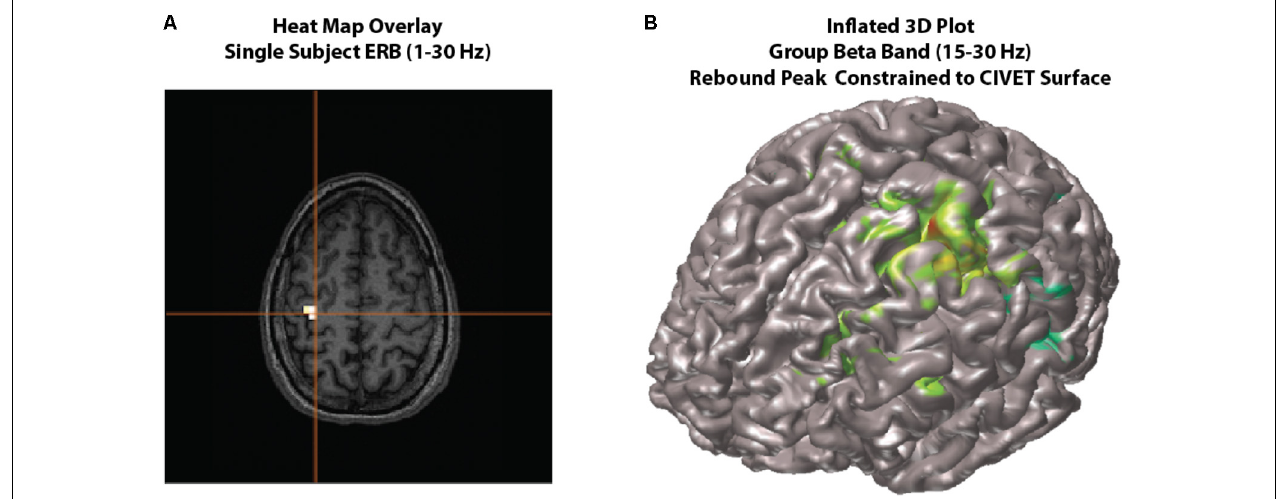
FIGURE 4 | Viewing options. Examples of viewing options for source images. (A) Individual subject results can be overlaid onto their own MRI in the MRIViewer module. This example shows evoked activity (ERB) response of subject 002, overlaid onto their own MRI. Single subject or group images can also be viewed on a built-in template brain surface [FreeSurfer extracted pial surface from the Colin-27 (CH2.nii) average brain] or an averaged extracted pial surface from CIVET. (B) Shows an example synthetic aperture magnetometry (SAM) group analysis of a beta band (15–30 Hz) rebound peak, constrained to a CIVET extracted